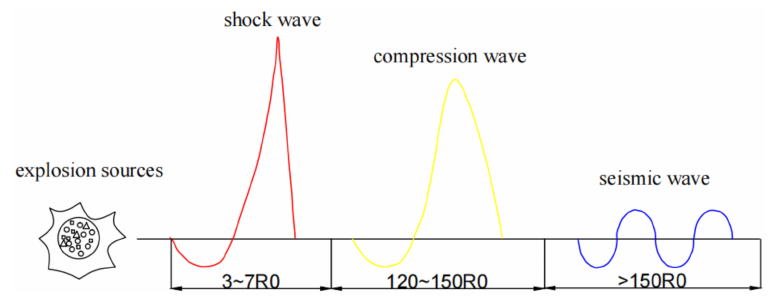
Figure 2. Diagram of stress wave